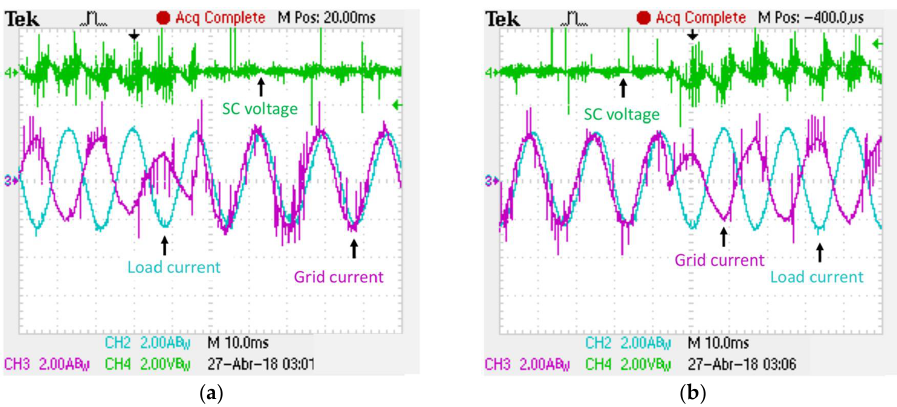
Figure 13. Experimental results of the transitory response ( a ) active power generation stops being available, ( b ) active power generation begins to be available.